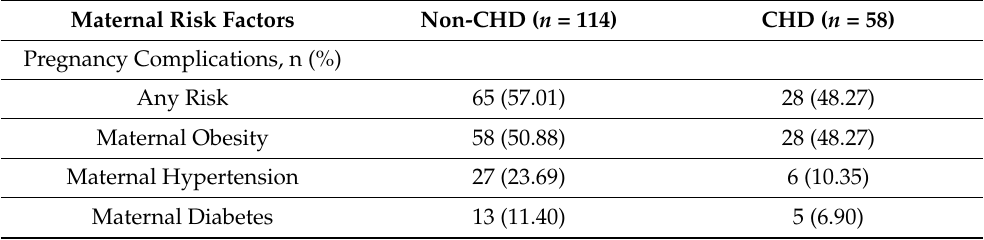
Table 2. Incidence of Maternal Risk Factors in CHD and Non-CHDs Groups. Maternal Risk Factors Non-CHD ( n = 114) Pregnancy Complications, n (%) Any